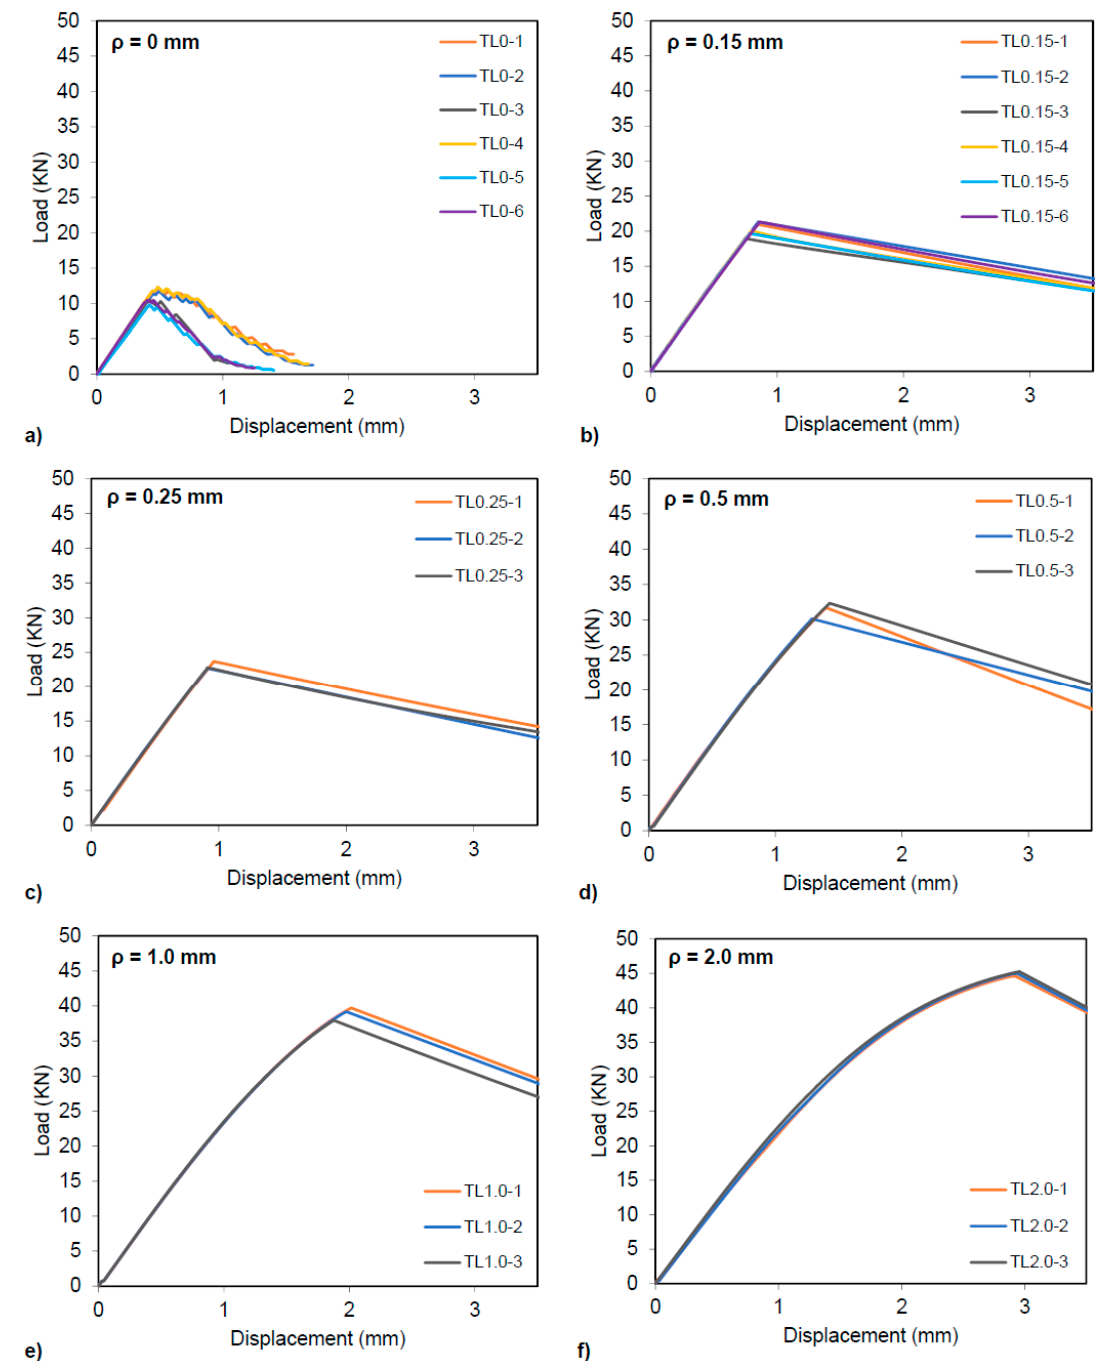
Figure 6. Load-Displacement curves for TL specimens with different notch radius. ( a ) 0 mm, ( b ) 0.15 mm, ( c ) 0.25 mm, ( d ) 0.5 mm, ( e ) 1 mm, ( f ) 2 mm [3].